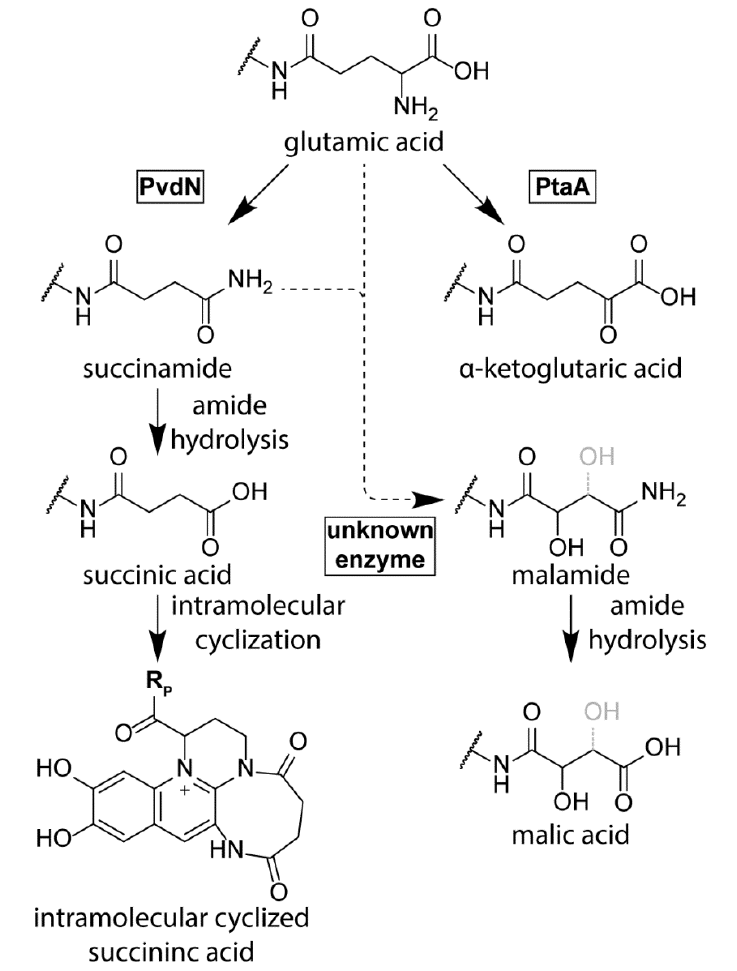
FIGURE 3: The branched periplasmic pathways for pyoverdine tailoring. PvdN generates the succin- amide residue and PtaA the α-ketoglutarate resi- due from glutamate. An unknown enzyme con- verts succinamide (most likely) or possibly glutam- ic acid to malamide in some species. The lower abundant succinic acid and malic acid pyoverdine forms are likely hydrolysis products of the corre- sponding amides. Note that the exact position of the hydroxyl group in malamide and malic acid residues is not